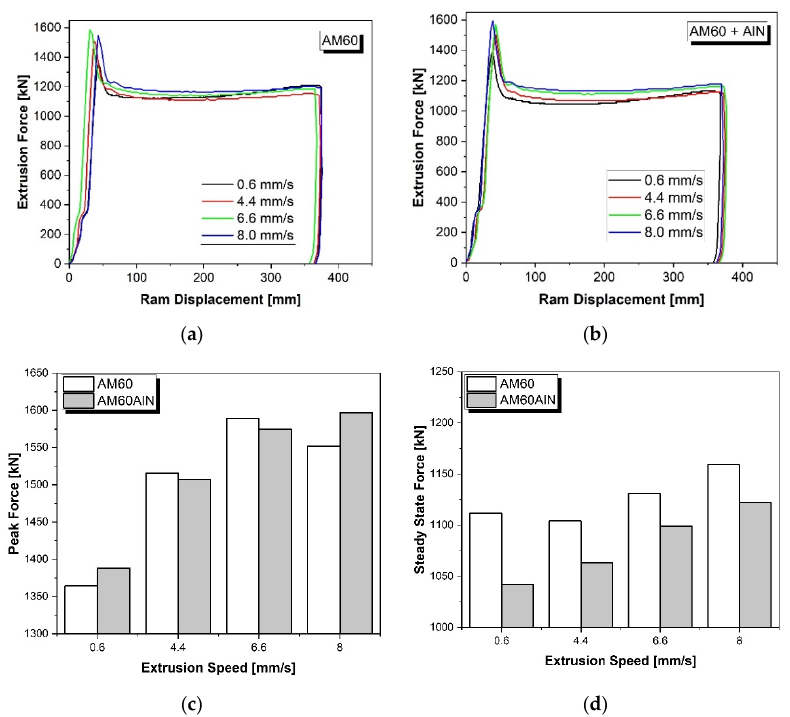
Figure 1. Indirect extrusion diagrams of the AM60 alloy ( b ) with and ( a ) without AlN nanoparticles. Peak forces ( c ) and steady state forces ( d ) of both materials at different extrusion